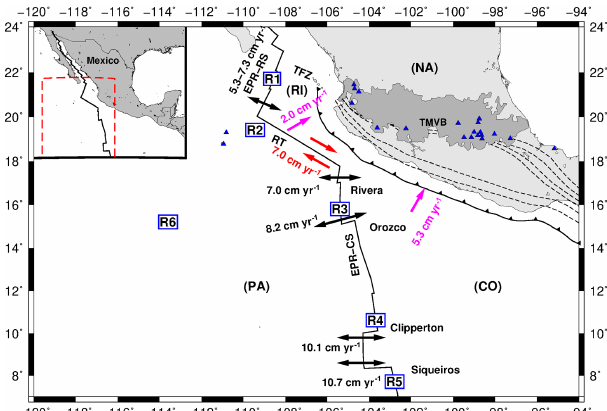
Figure 1. Main tectonic features in the oceanic environment off the Pacific coast of Mexico discussed in the text. CO is the Co- cos Plate; NA is the North American Plate; PA is the Pacific Plate; RI is the Rivera microplate; TMVB is the Trans-Mexican Volcanic Belt; TFZ is the Tamayo Fracture Zone; EPR-RS is the East Pa- cific Rise Rivera segment; EPS-CS is the East Pacific Rise Cocos segment; and RT is the Rivera Transform. Blue triangles are volca- noes. Dashed lines show contour lines of the subducted slab. Arrows indicate the motion of the PA, CO, and RI plates. R1 to R6 are the regions in which the study area was divided for analyzing stress and seismicity characteristics. Red number indicates the slipping rates. Pink numbers indicate convergence rates, and black numbers indi- cate spreading